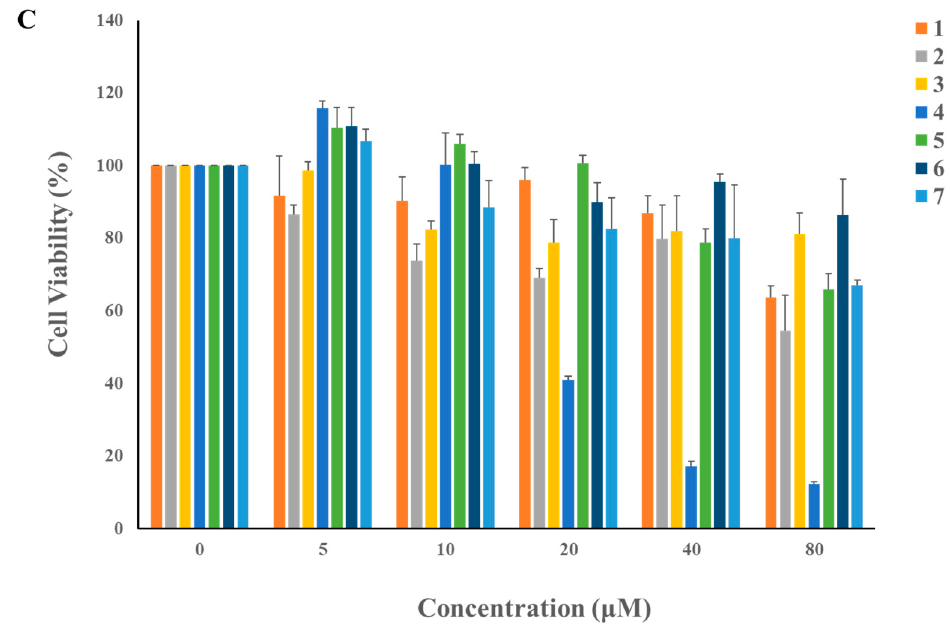
Figure 5. Suppressive effects of compounds 1 – 7 on adipogenic differentiation. C3H10T1/2 cells were treated with sequential concentrations (1, 5, 10, and 20 µ M) of the compounds for nine days prior to ORO staining. ( A ) Stained cells were quantitatively evaluated by resolving stained lipid droplets and measuring absorbance at the red wavelength; ( B ) 20 µ M of resveratrol (denoted as Res) was used as the positive control. The values were relatively calculated by setting the untreated negative control to 100. C3H10T1/2 cells were treated with higher concentrations (5, 10, 20, 40, and 80 µ M) of the compounds to evaluate the cellular toxicity; ( C ) Cell viability was calculated relatively by setting the untreated negative control to 100. * denotes 0.01 < p < 0.05, ** denotes 0.001 < p < 0.01, and *** denotes p < 0.001.